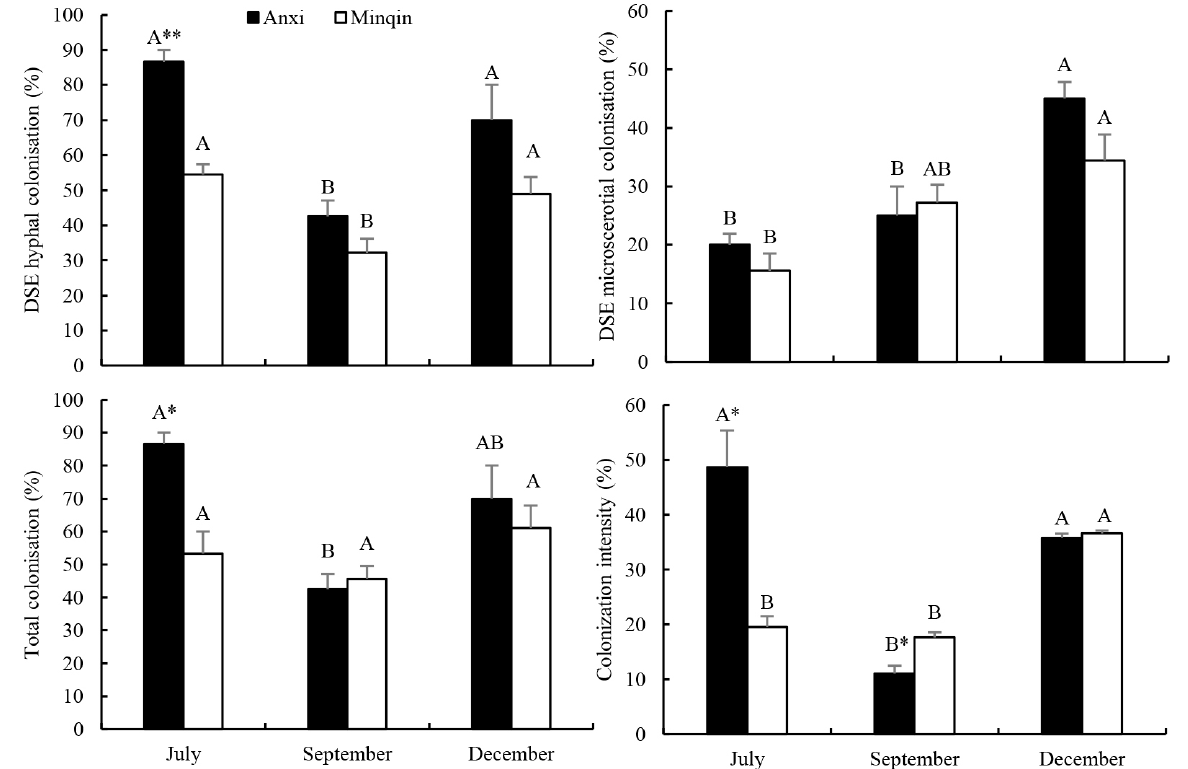
Figure 2. Temporal and spatial changes of DSE colonization in L. ruthenicum roots. Significant ( p < 0.05) differences among different months marked with different letters. Significant ( p < 0.05) differences among different sites marked with * (* indicates a significant difference at p < 0.05 and ** indicates a significant difference at p < 0.01).